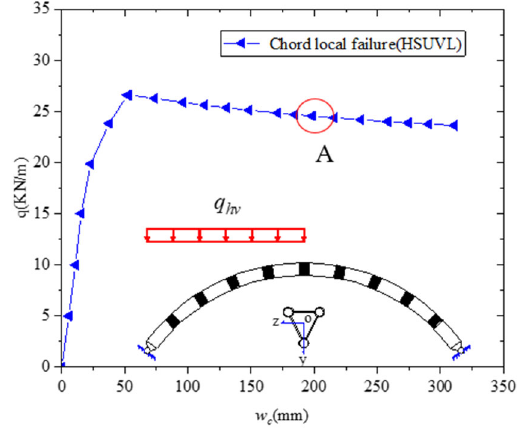
Figure 32. Load–displacement curve of chord local failure under HSUVL.